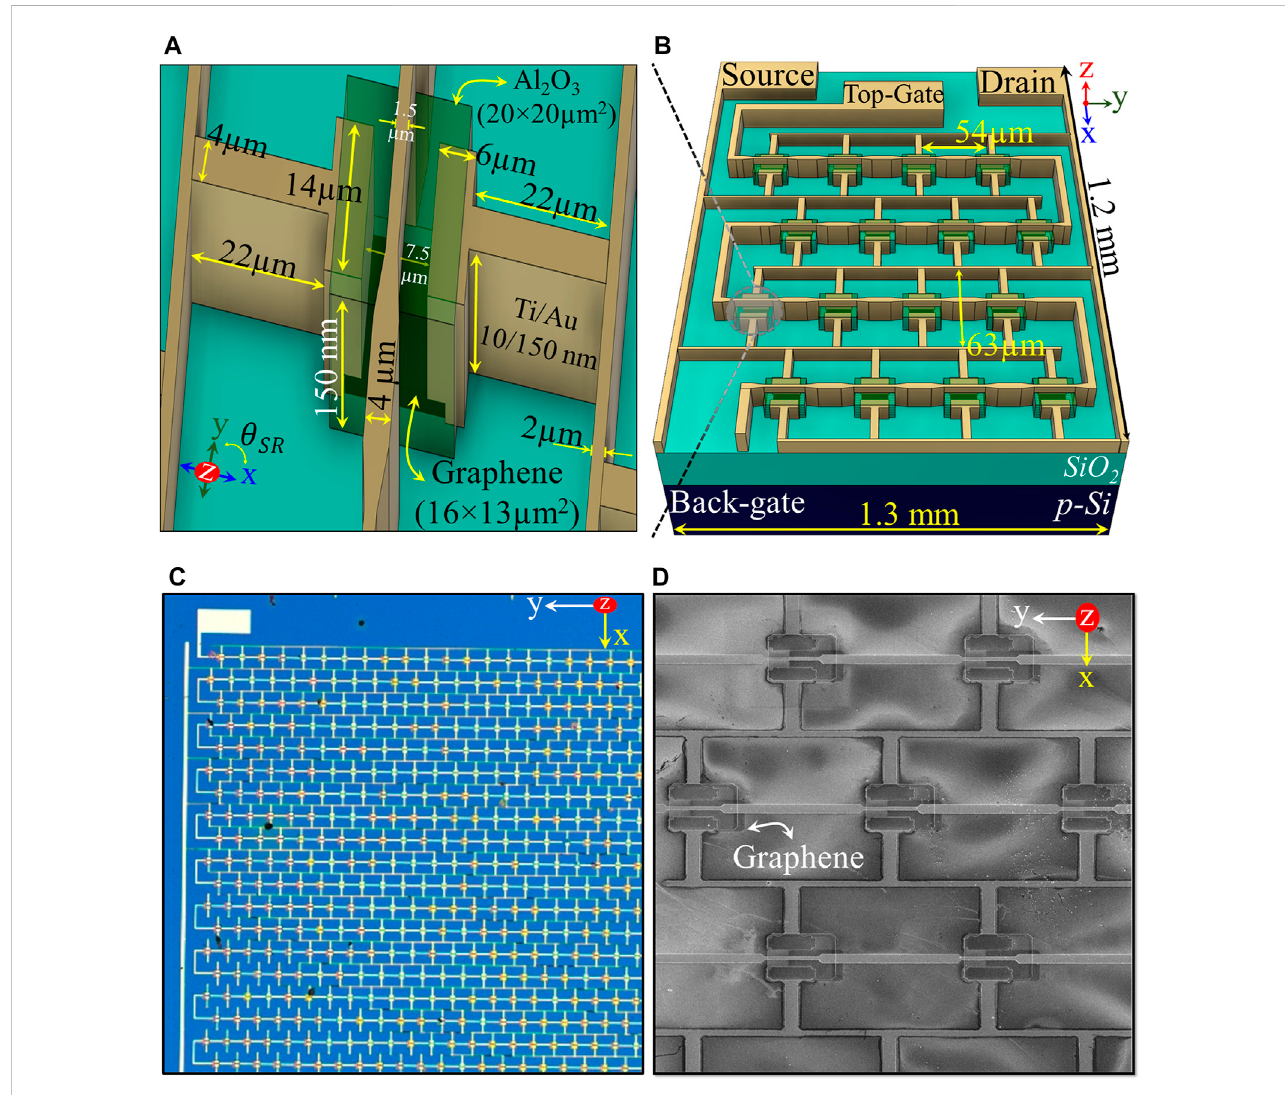
FIGURE 1 (A) Aunite-cellschematicpictureshowingitsdimensions. (B) Top-viewschematicpictureofacompletegatedSRsarray. (C) Opticalmicroscopeand (D) SEM pictures of the fabricated SRs